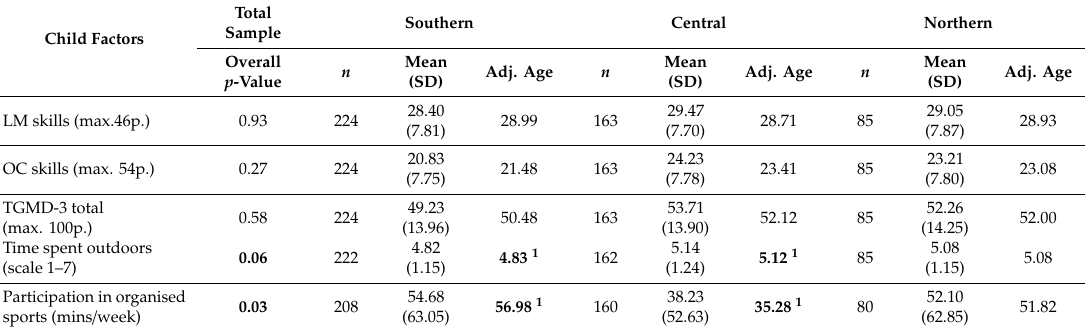
Table 3. Geographic location: di ff erences in